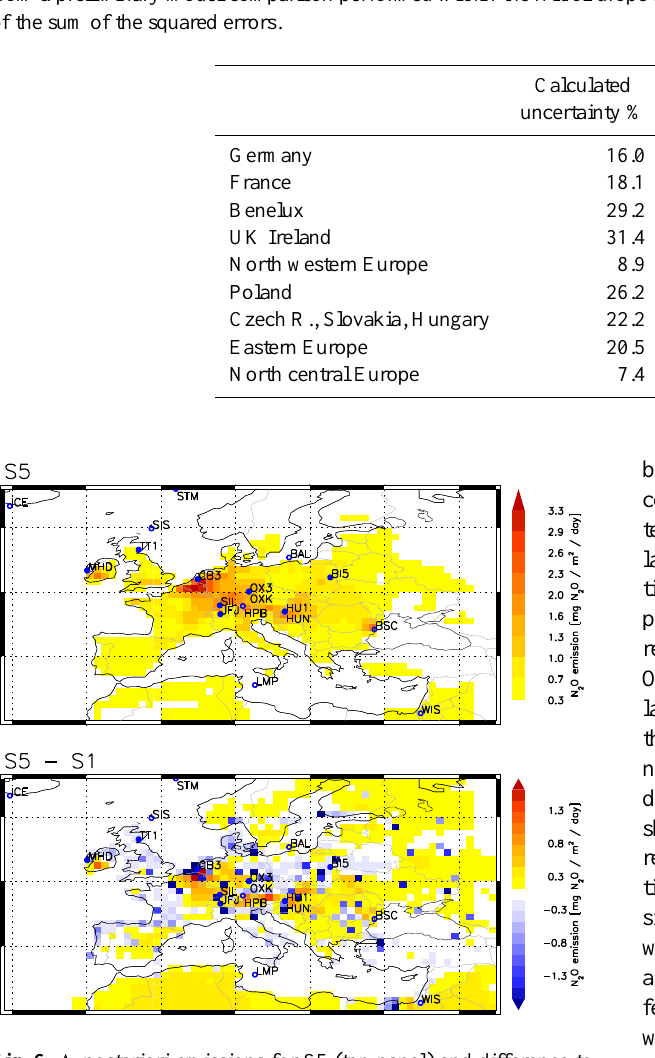
Fig. 6. A posteriori emissions for S5 (top panel) and difference to reference inversion S1 (mid panel of Fig.